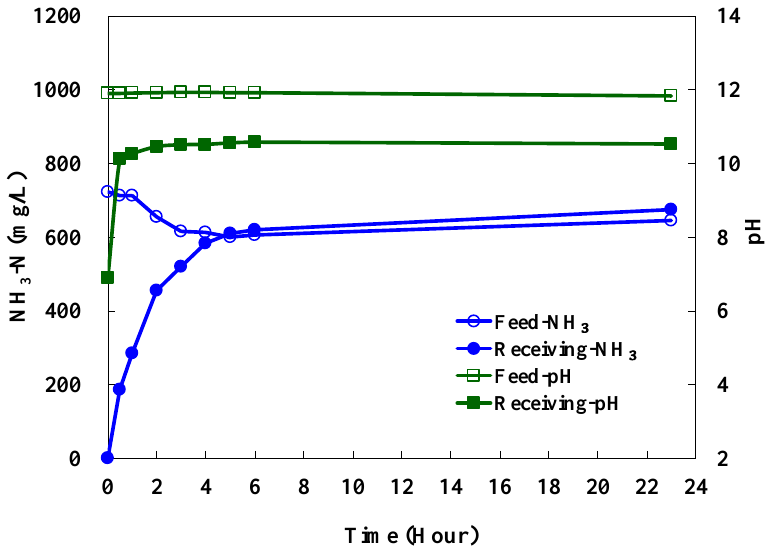
Figure 6. The NH 3 -N concentrations and pH in both feed and receiving solutions as a function of time using PTFE hollow fiber membranes (receiving solution: distilled water, 10 °C).